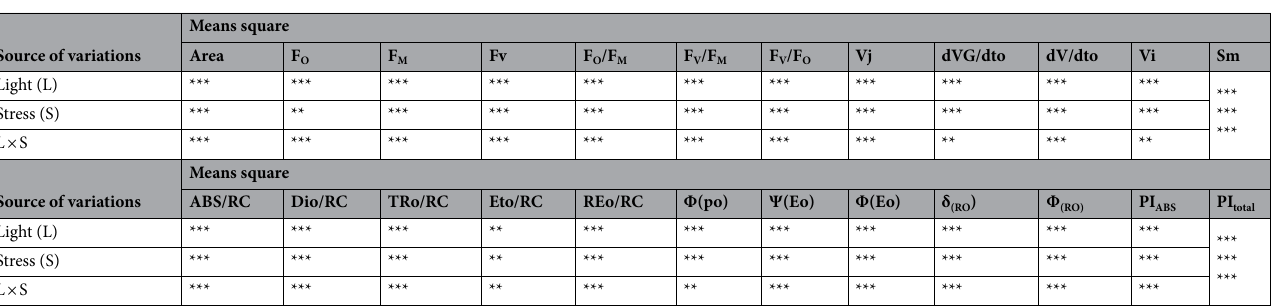
Table 3. ANOVA results of different light spectra and stress on JIP-test parameters in strawberry cv. Paros. *, **, ***Significance at the 0.05, 0.01, and 0.001 probability levels, respectively, ns, not significant. SAS